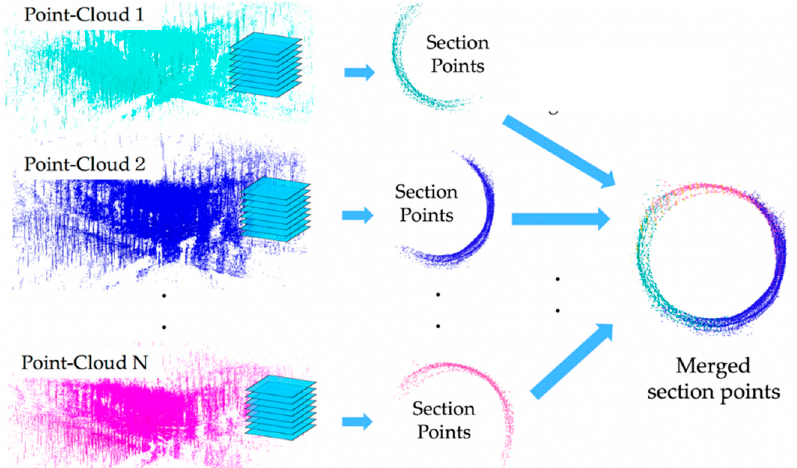
Figure 9. Section points merged on each horizontal plane.